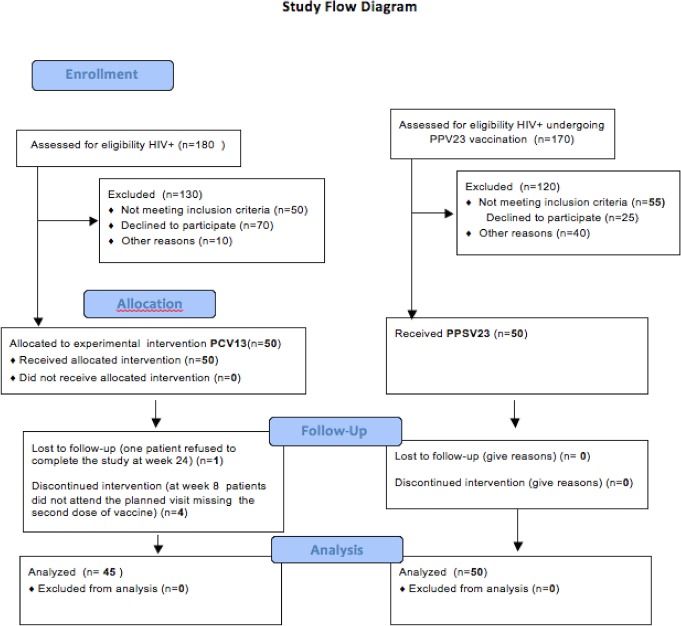
Flow chart illustrating the entire study population.CONSORT flow diagram.